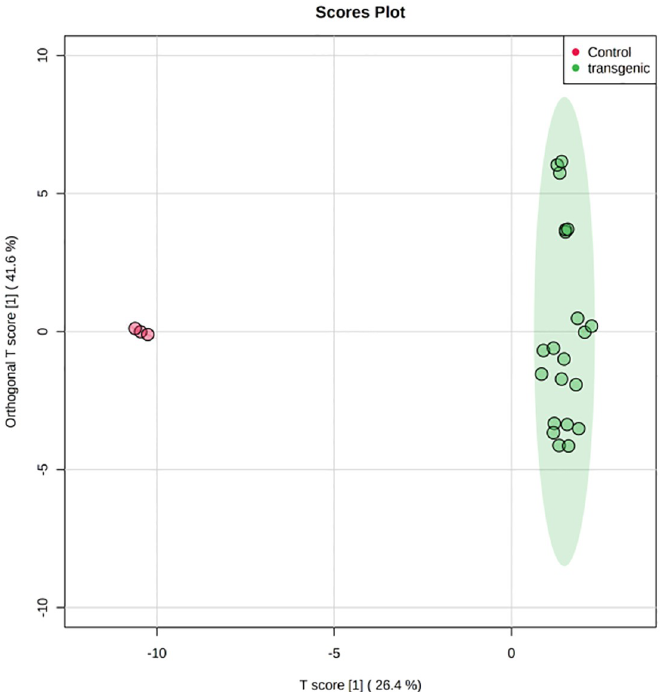
Fig 14. OPLS-DA plot of control and transgenic lines on the leaf metabolic profiles.